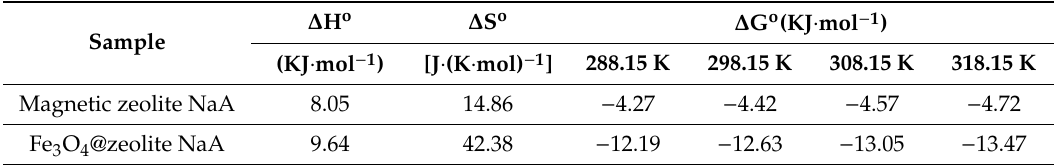
Figure S1: TEM image of magnetic zeolite NaA, Figure S2: Separation ability test of Fe 3 O 4 @zeolite NaA, Table S1: XRF analyze of